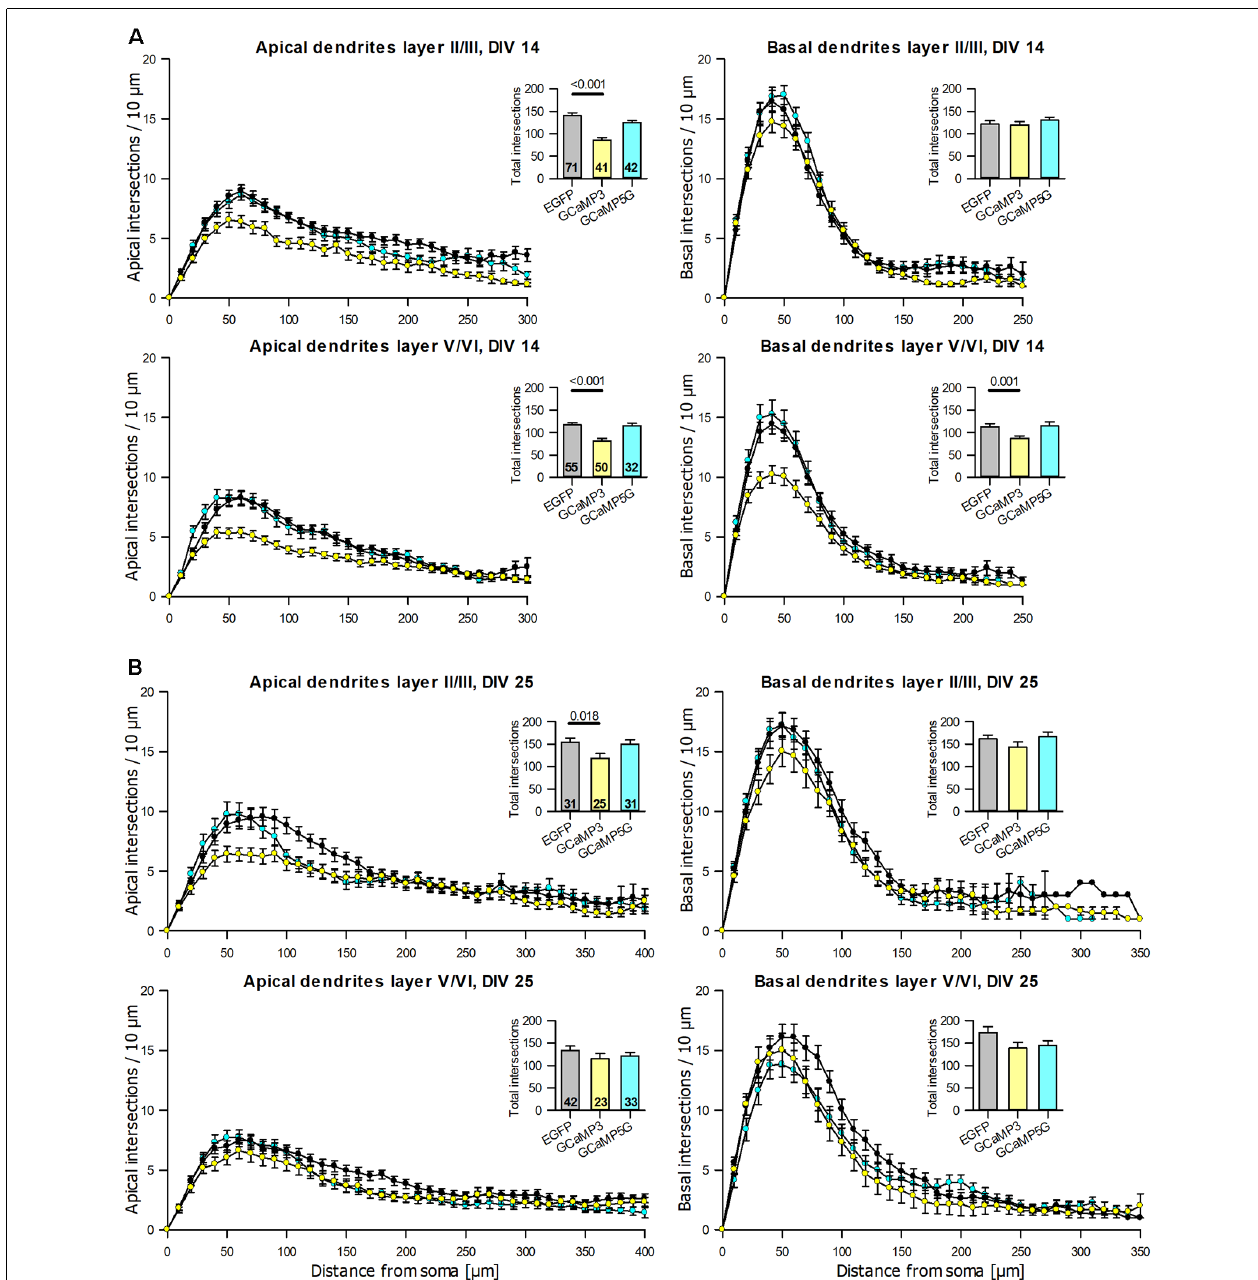
FIGURE 5 | Sholl analyses of apical and basal dendrites of pyramidal neurons of layers II/III and V/VI expressing GCaMP3 and GCaMP5G, respectively, vs. batch-internal EGFP expressing neurons. (A) DIV 14. (B) DIV 25. Insets report total intersections. P values of the Mann–Whitney rank-sum test vs. control performed after the ANOVA on ranks indicated a significant difference vs.